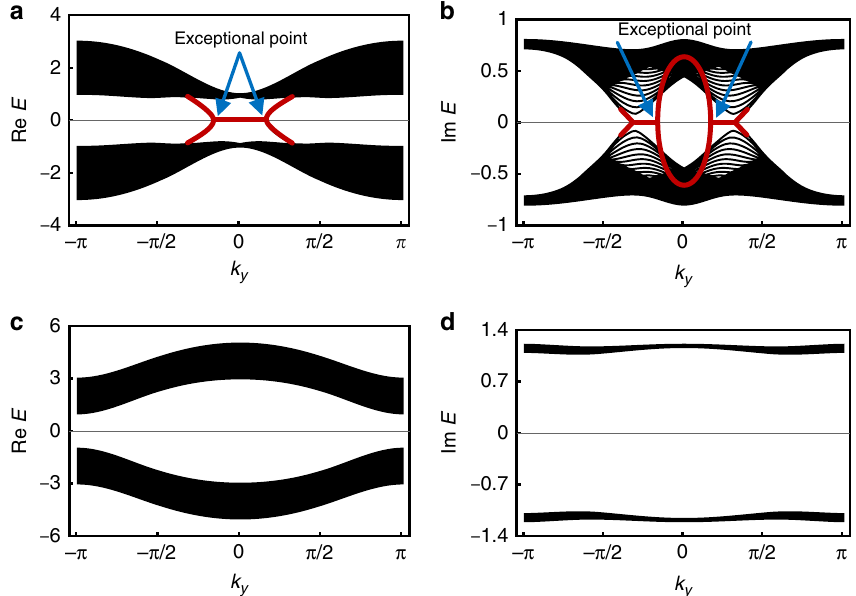
Fig. 5 Non-Hermitian quantum spin Hall insulator. The results shown are for the model described by Eq. (7) with d 1 ( k ) = m + t cos k x + t cos k y , d 2 ( k ) = t sin k y , d 3 ( k ) = λ (sin k x + sin k y ), d 5 ( k ) = t sin k x , and d 25 ( k ) = γ t ; m ; λ ; γ 2 R ð Þ . We here consider a non-Hermitian two-dimensional insulator on a square lattice with open boundaries in the x direction and periodic boundaries in the y direction, along which the wavenumber k y is well-de fi ned. The Z 2 topological invariant is given by (cid:2) 1 ð Þ ν AII ¼ sgn ½ m 2 (cid:2) 4 t 2 (cid:6) . a Real and b imaginary parts of the complex spectrum in the topological phase ( t = 1.0, m = -1.0, λ = 0.5, γ = = 1). Helical edge states (red curves) appear between the gapped complex bands and form a pair of exceptional points. c Real and d imaginary 0.8; ν AII parts of the complex spectrum in the trivial phase ( t = 1.0, m = 3.0, λ = 0.8, γ = 1.2; ν